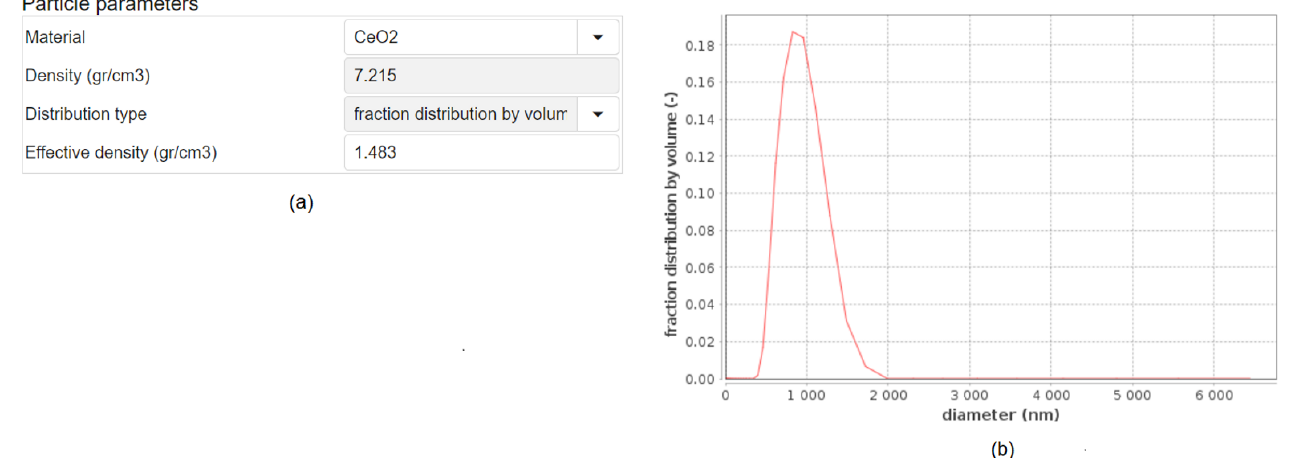
Figure 2. The Particle parameters section of the “in vitro dosimetry” web application. ( a ) The basic input parameters. The user can select from various NPs whose parameters are pre-loaded, or can define new NPs and input the required information on density and effective density themselves, as well as the particle size distribution type (i.e., volume distribution (mass) or particle number distri- bution). ( b ) Illustration of the particle size distribution of the CeO 2 NPs dispersed in Eagle′s mini- mum essential medium (EMEM) cell culture medium with 10% fetal bovine serum presented as the fraction distribution by volume for the specific NP.